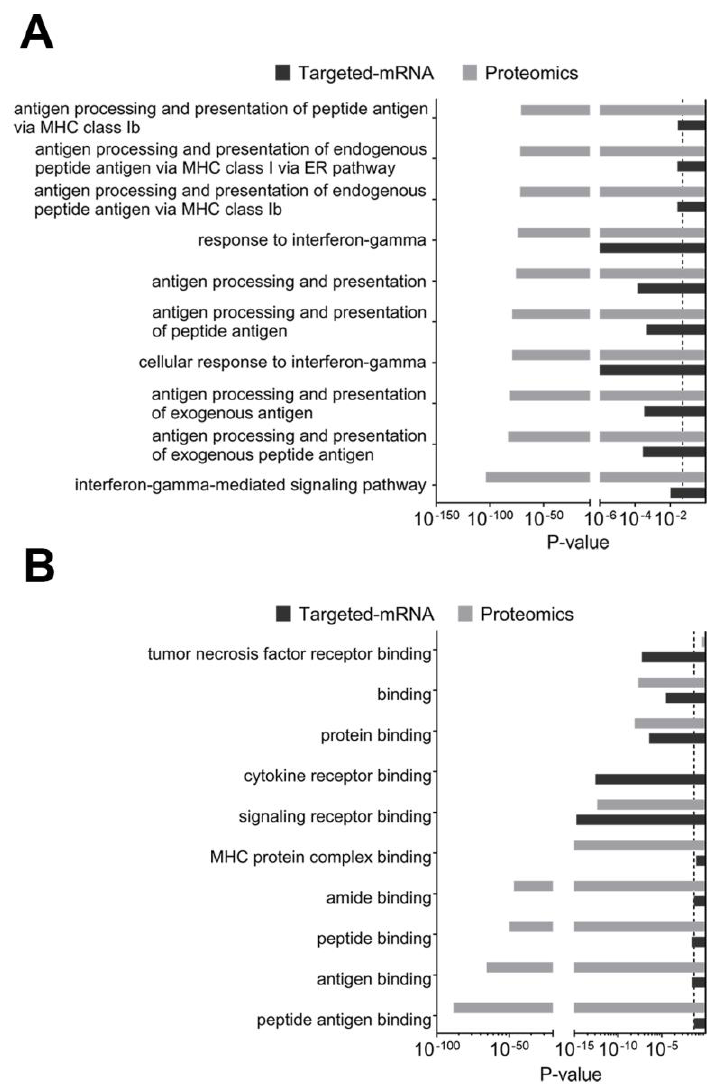
Figure 3. Composite enrichment analysis of proteomics and targeted-mRNA for public gene ontology. ( A ) Analysis for public GO: biological processes. ( B ) Analysis for public GO: molecular function. Dotted line represents p -value cutoff of 0.05.